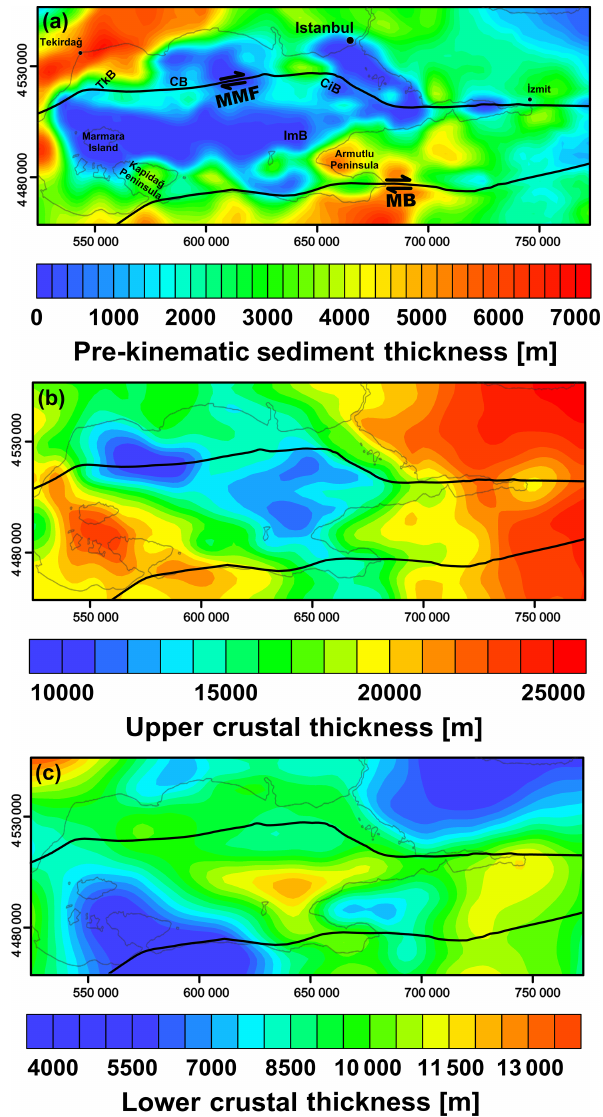
Figure 6. Differentiated crustal structural model integrating seis- mic observations along the profiles in Fig. 4 (WGS84, UTM zone 35 ◦ N). (a) Pre-kinematic sediment thickness. (b) Upper crystalline crustal thickness. (c) Lower crystalline crustal thickness. Abbrevi- ations: main Marmara fault (MMF), middle branch of NAF (MB), Çınarcık basin (CiB), Central basin (CB), Tekirda˘g basin (TkB), and Imralı basin